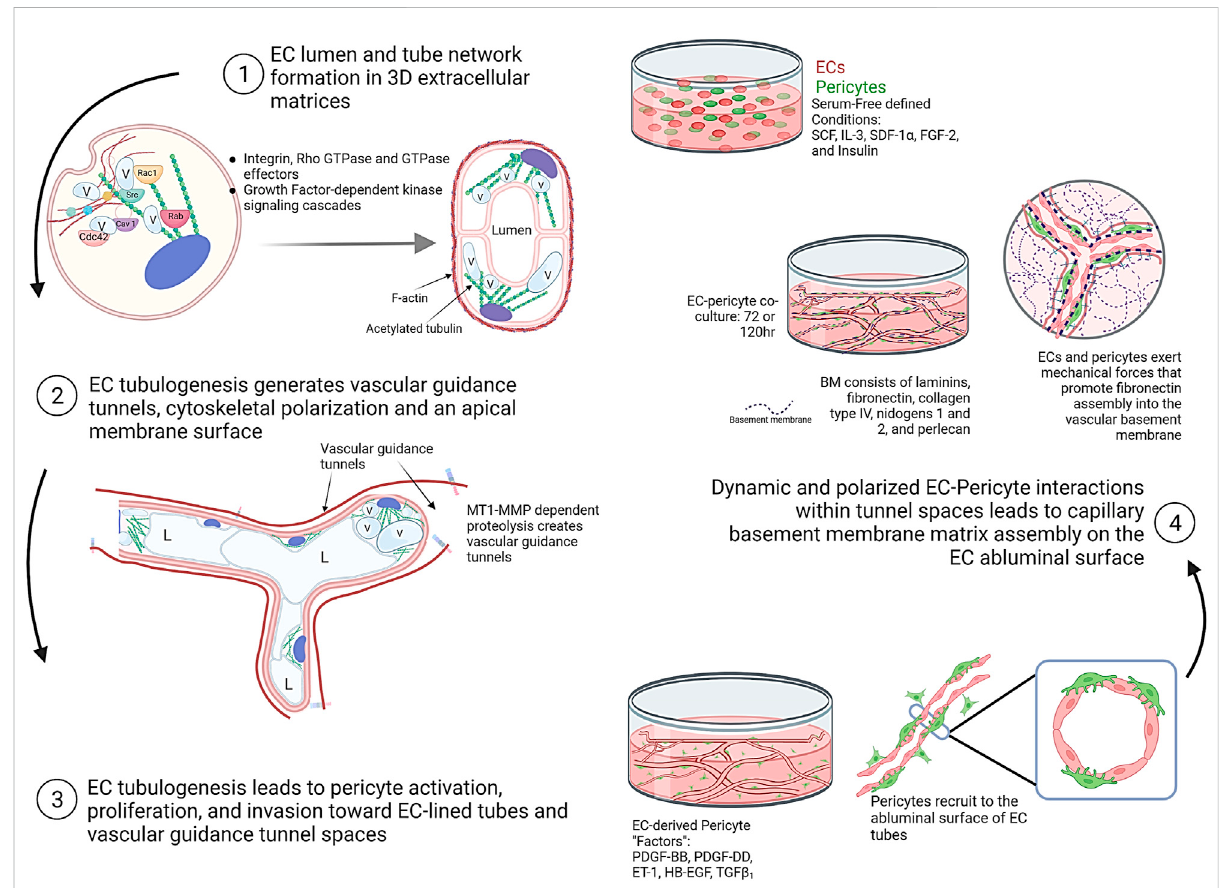
Schematicillustrationsshowingthefundamentalandinterconnectedstepscontrollingtheassemblyofhumancapillarytubenetworks.Fourkey